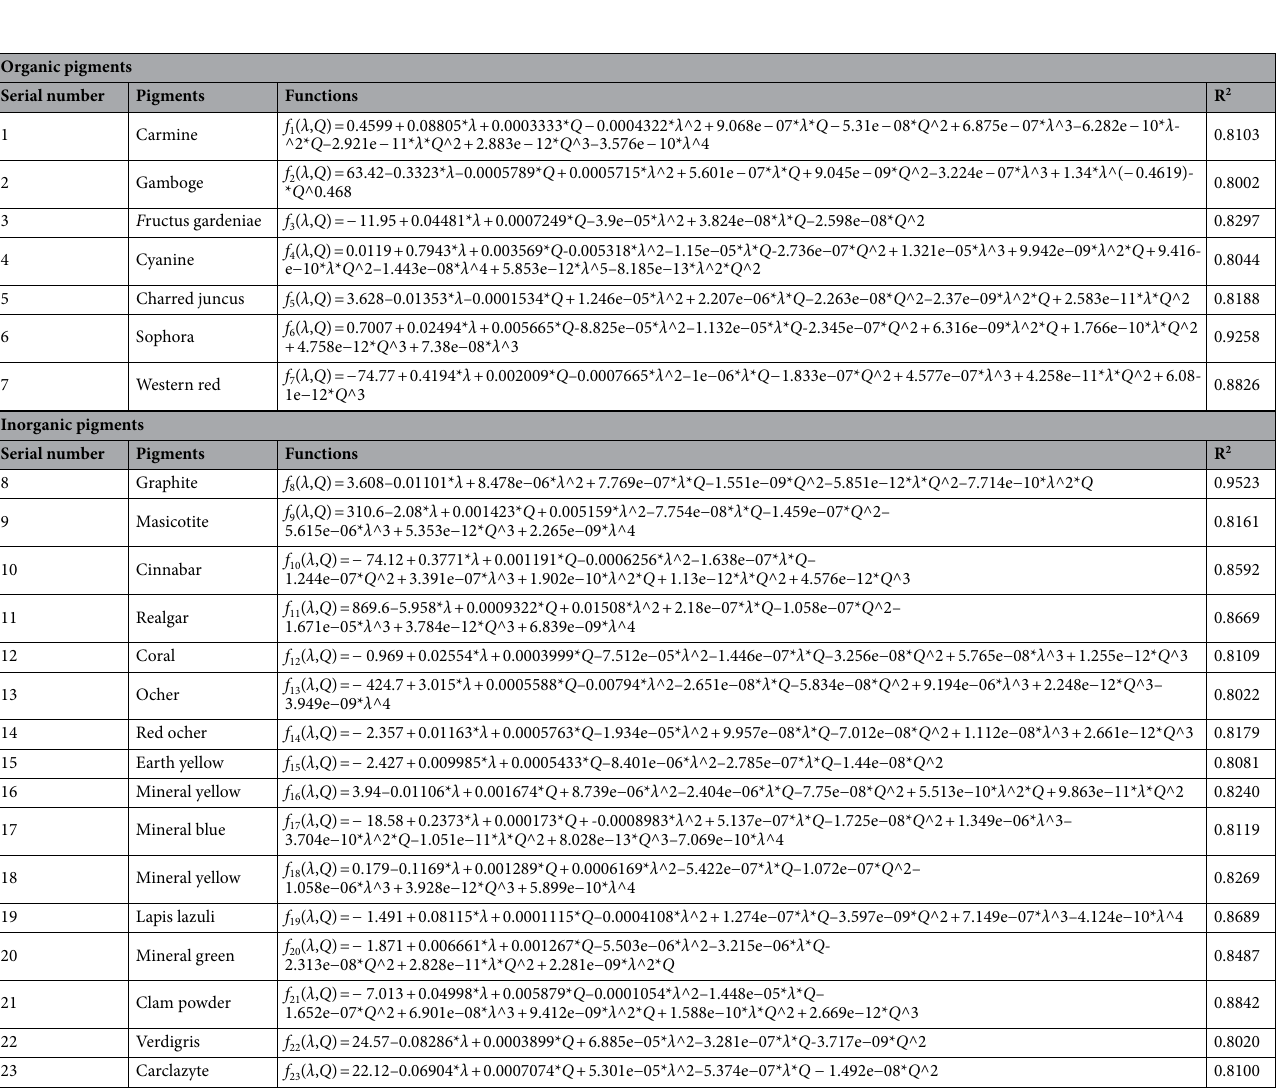
Table 2. The relative responsivity functions of 23 pigments to exposure and SPD.